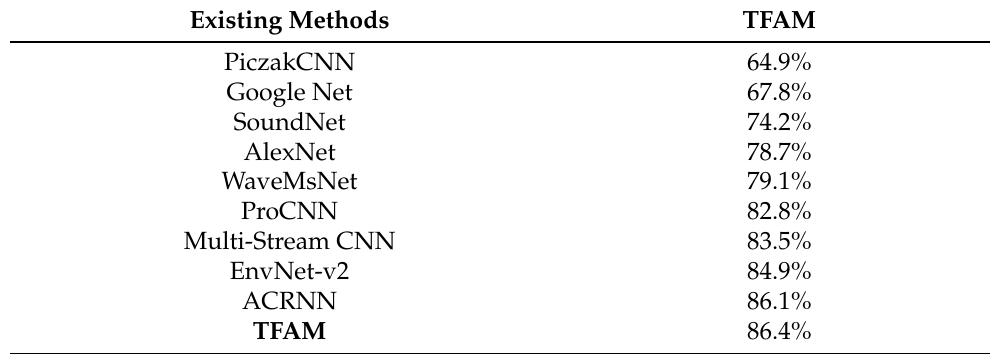
Table 12. Classification accuracy